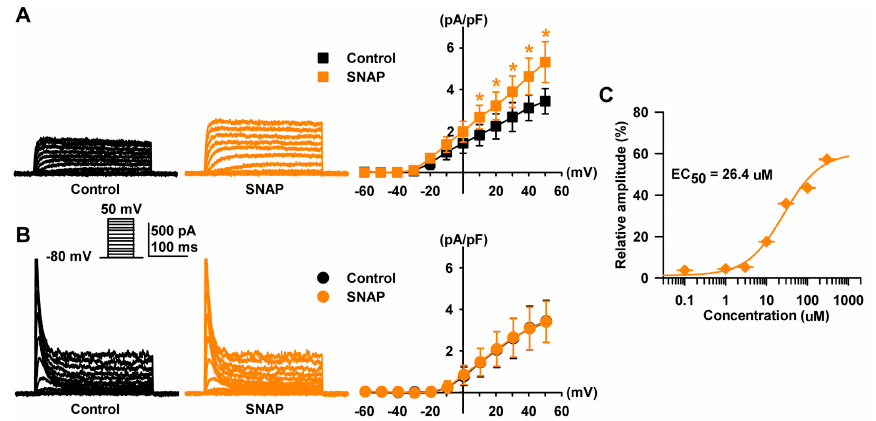
Figure 4. Effect of nitric oxide (NO) on two subtypes of K V currents. Raw data and the I-V relationship of steady-state currents changed by the presence of SNAP on ( A ) delayed rectifier K + current (I K ) and ( B ) transient outward K + current (I to ). ( C ) The concentration-response curve of S-nitroso-N-acetylpenicillamine (SNAP) on I K . The continuous line represents the fit to the Hill equation. The normalized currents (percent inhibition) were calculated from the I K in the absence of SNAP and plotted against various concentrations of SNAP. * p < 0.05 versus the control.